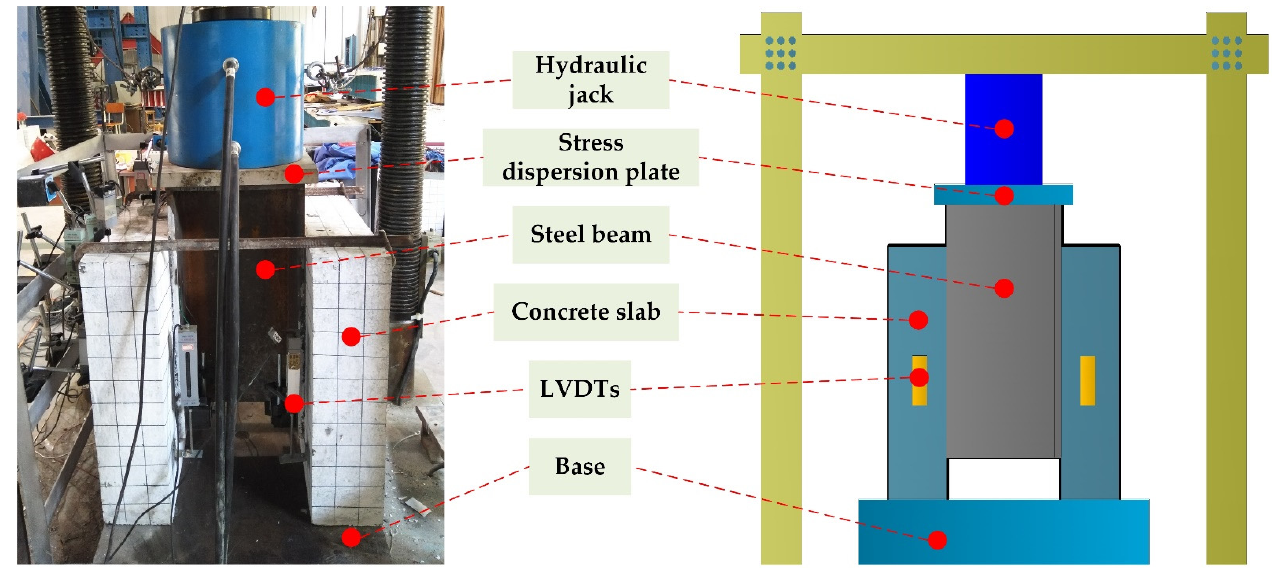
Figure 4. Push-out test setup.